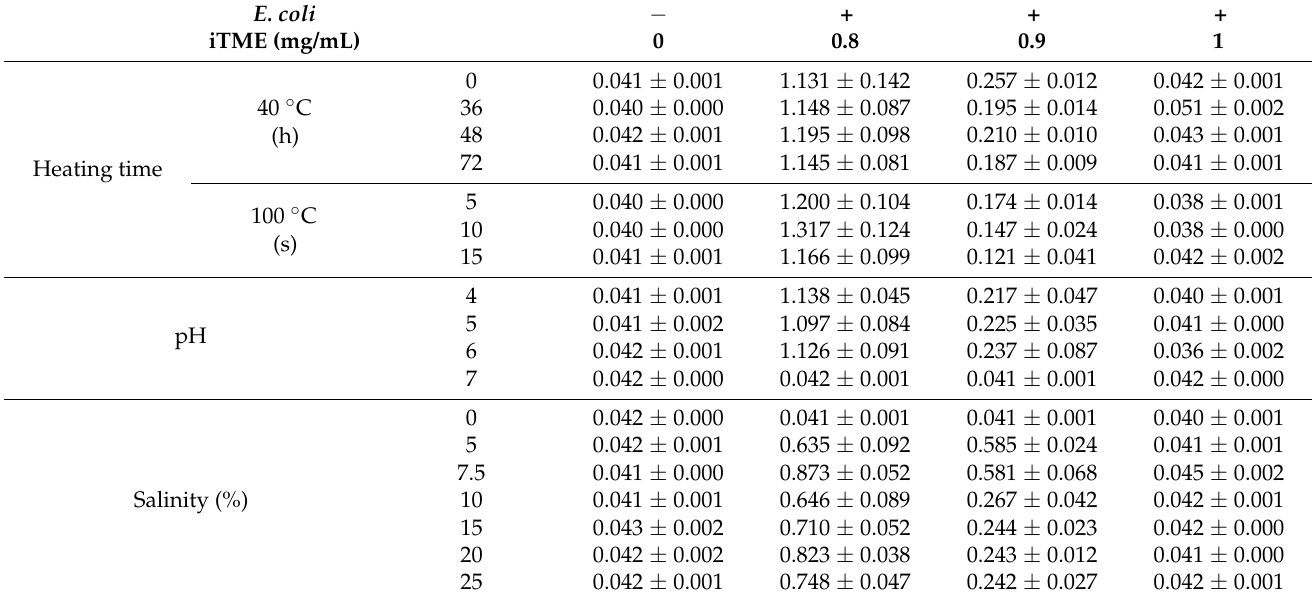
Table 3. Stability analysis of iTME under varying temperature, pH, and